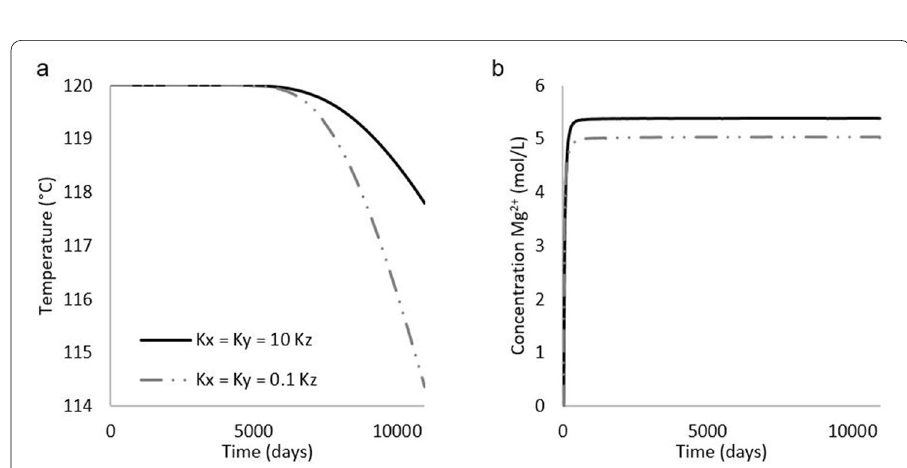
Fig. 8 Comparison of sensitivity to anisotropy for a observed temperature at the production well and b Mg 2 + at the production well in a geothermal doublet